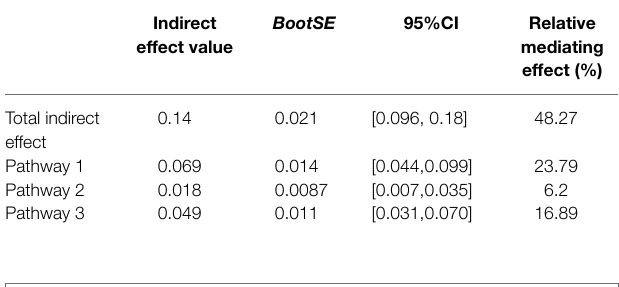
TABLE 3 | Mediating effect analysis of parental phubbing and depression.